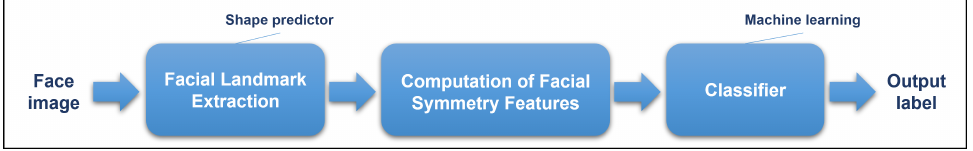
Figure 1. Framework of the proposed facial palsy assessment